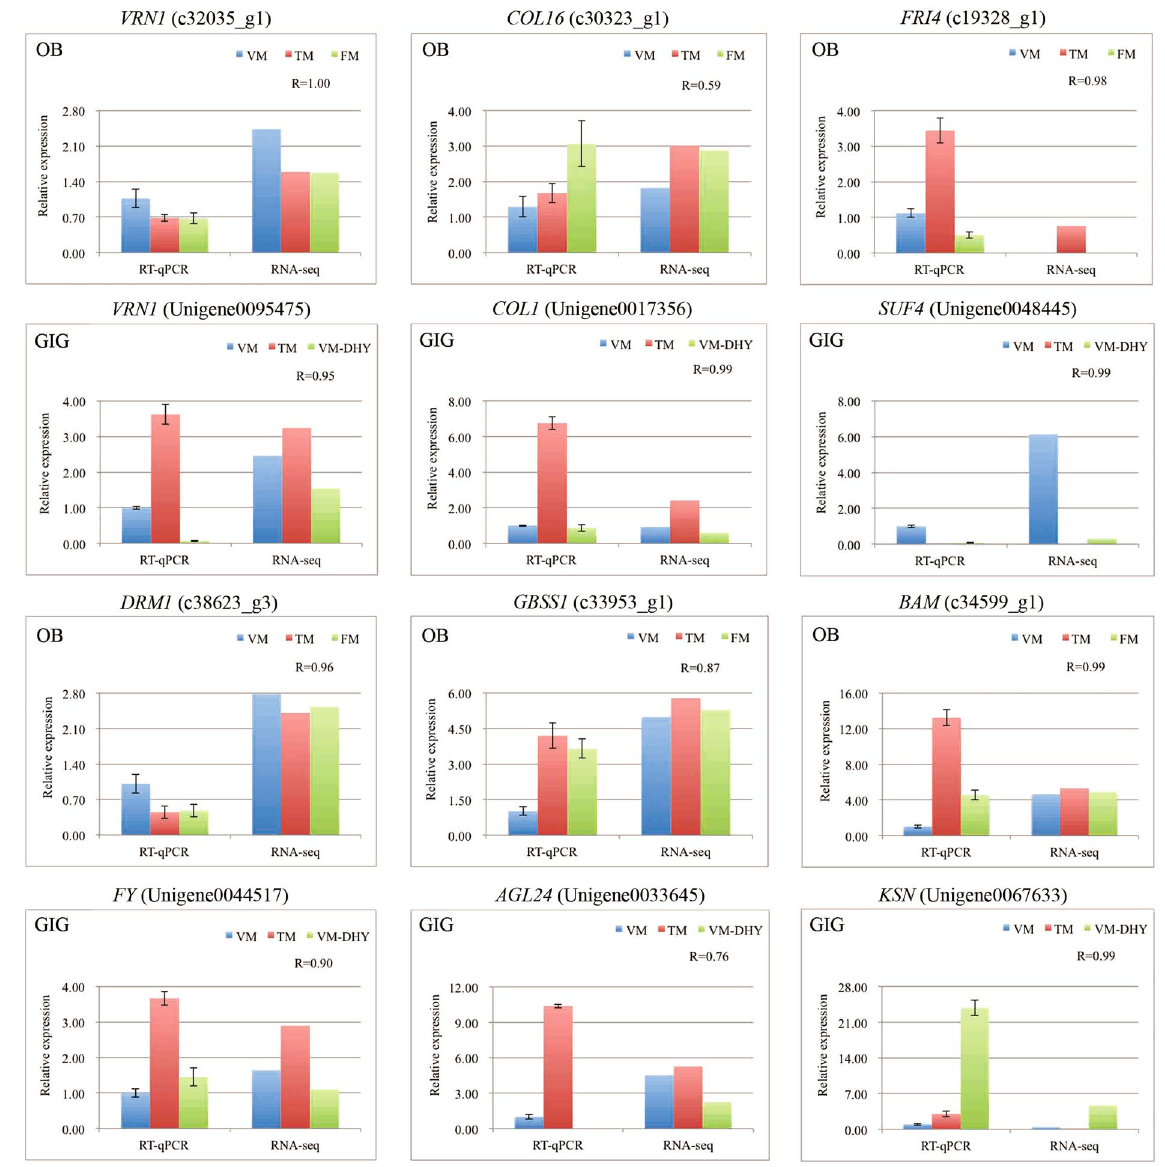
Figure 4. RT-qPCR validation of key candidate floral DEGs in different developmental stages of OB and GIG. The expression levels of genes revealed by RT-qPCR (left side) and RNA-seq (right side). Data from RT-qPCR were means of three replicates and bars represent SE. Data from RNA-seq were means of replicates and were normalized by Log 2 transformed. The correlation coefficient (R) for each gene between RT-qPCR and RNA-seq data was shown and calculated by cor.test in